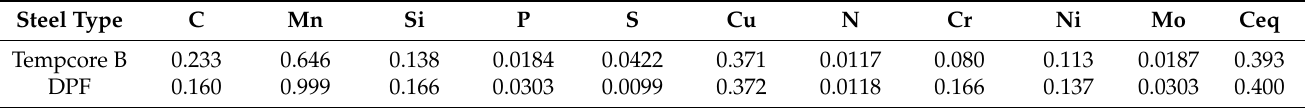
Table 1. Chemical composition (in %) of steel rebars Tempcore B and Dual Phase F (DPF). Steel